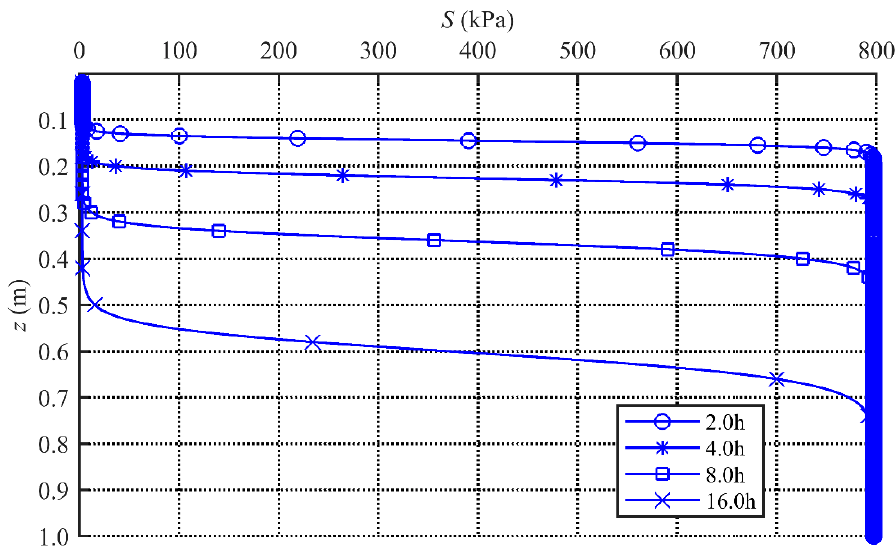
Figure 12. Matrix suction profiles at different times.